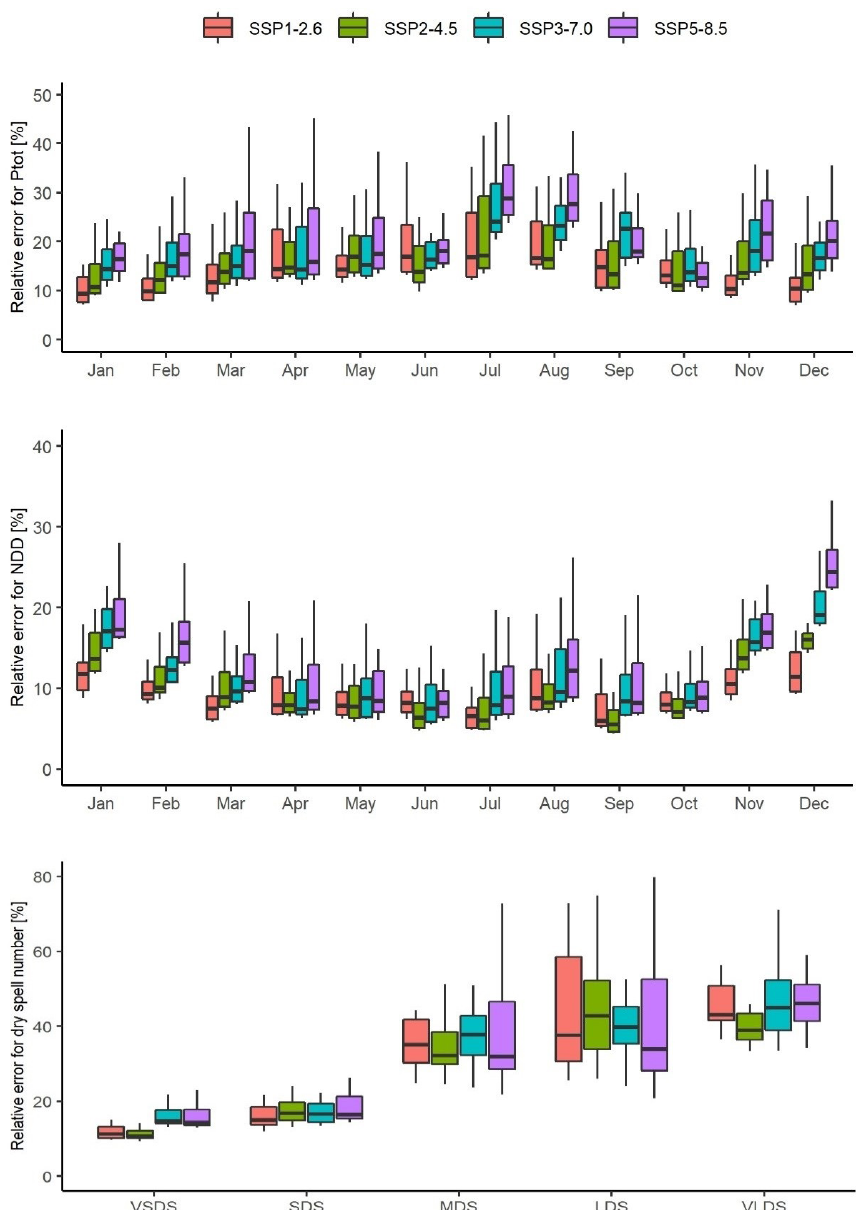
Figure 4. Relative error of the inter-model cross-validation of the BC method for the drought-related indicators (Ptot – monthly precipitation; NDD – number of dry days; dry spell number). VSDS, SDS, MDS, LDS and VLDS denote the very short, short, medium, long and very long dry spells defined in Table 4, respectively. The top and bottom of the box show the 75th and 25th percentiles of the relative error, respectively. The top and bottom of the whiskers show the 5th and 95th percentiles, respectively. The horizontal black line in the middle of the box represents the